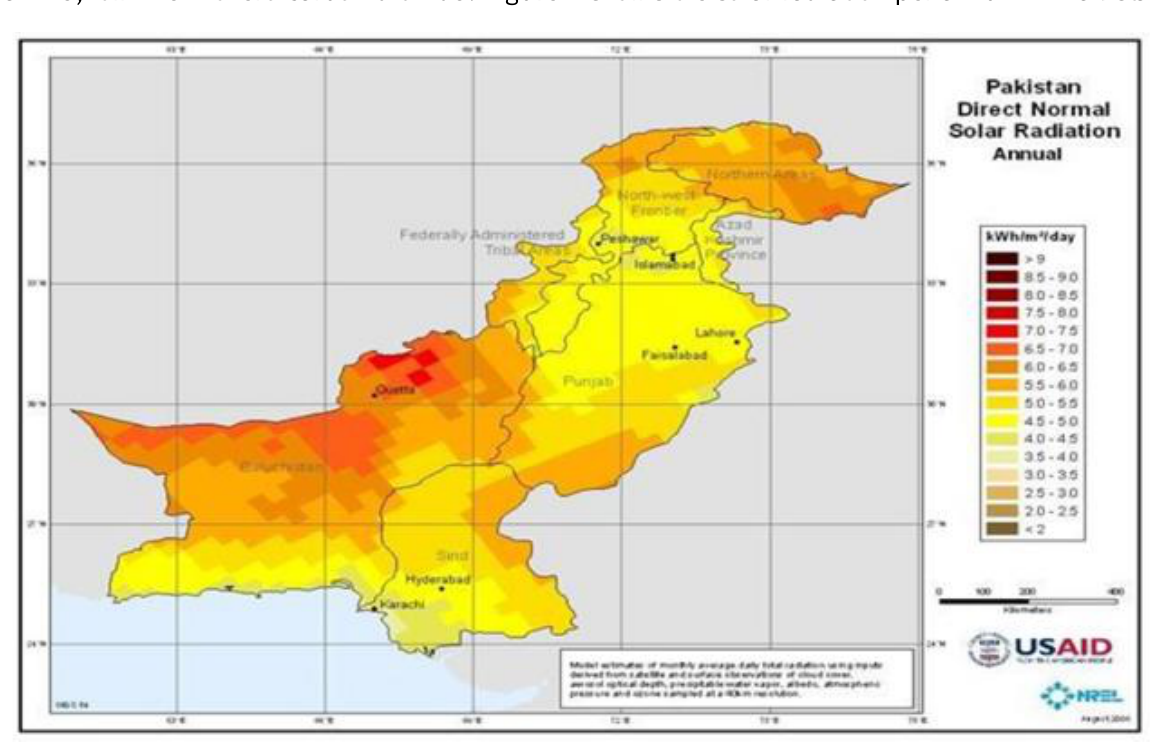
Figure 1. Solar Radiation per annum in